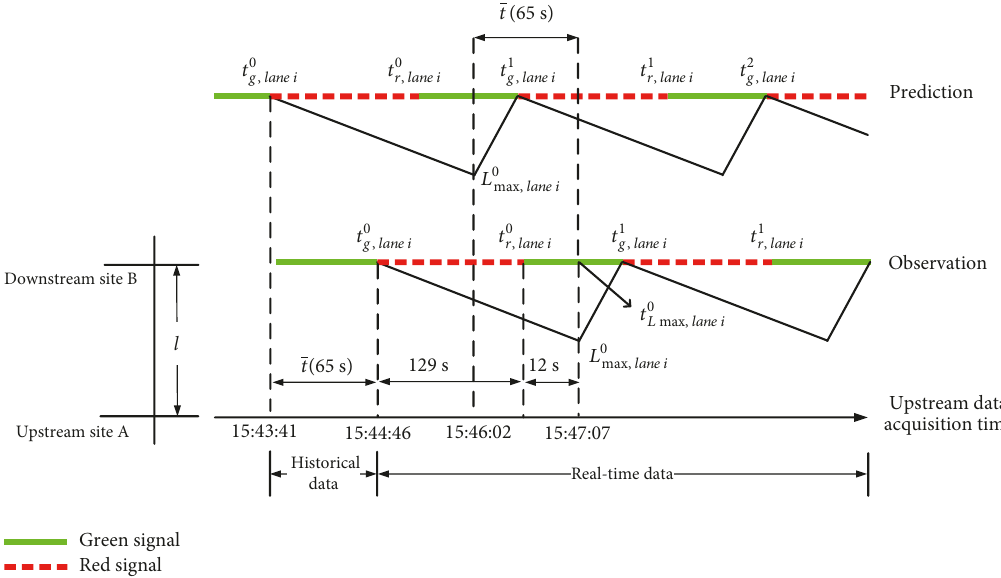
Figure 12: Queue length real-time prediction process (Lane